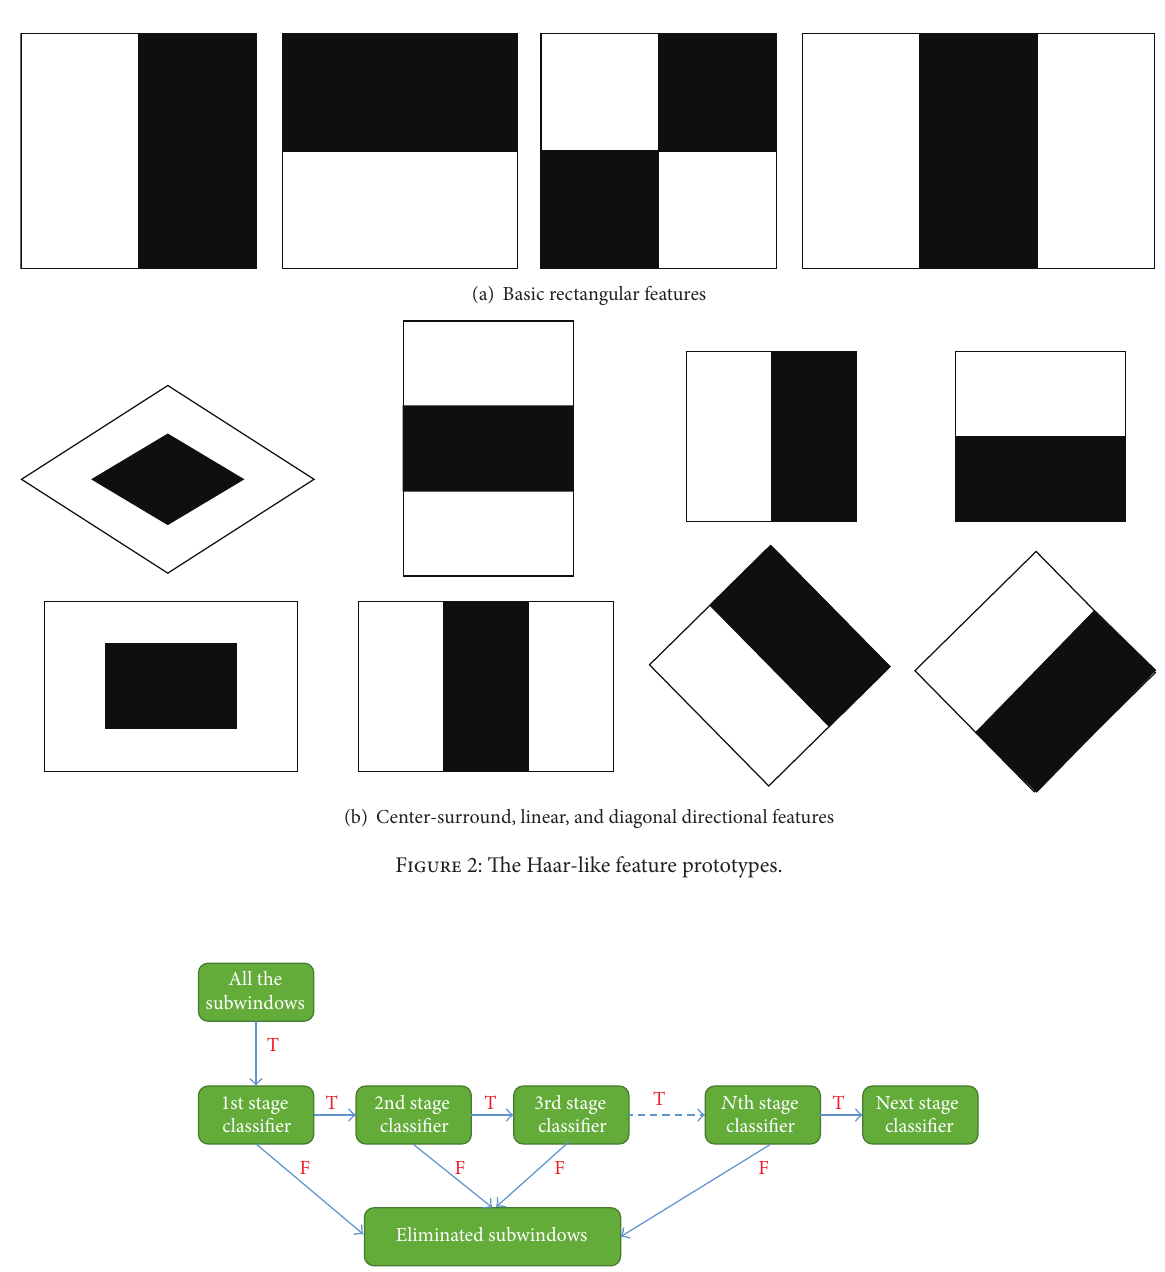
Figure 3: The cascaded